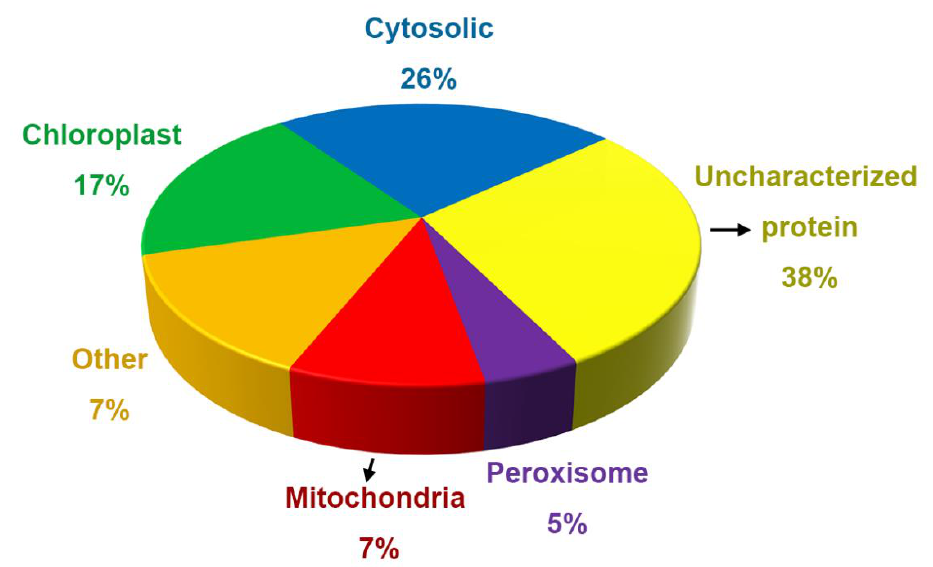
Figure 3. Percentage of the proteins in subcellular organelles in the salt gland secretion fluid of L. bicolor plants without NaCl treatment.